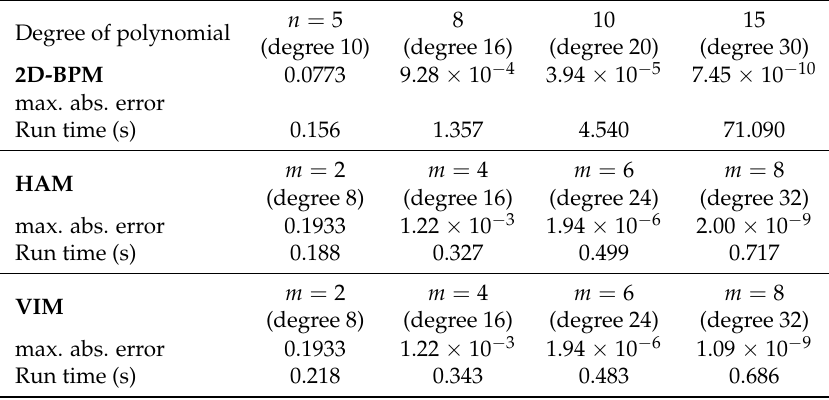
Table 4. The results of the 2D-BPM, HAM, and VIM for Example